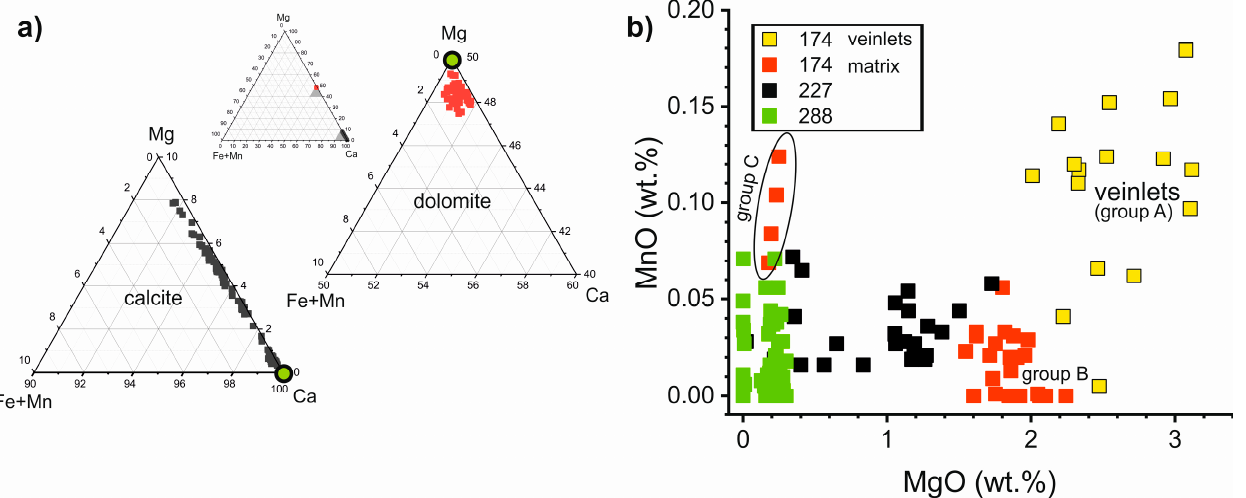
Figure 3. Summary of the chemical composition of the carbonate grains studied: ( a ) triangular plot of the main carbonate components. The composition of pure calcite and pure dolomite is indicated by green circles. The small triangle localizes the position of the two large triangles in the full-size plot; ( b ) the distribution of Mg- and Mn-admixture in calcite. Note the positive linear correlation between Mg and Mn for most of the data of sample No. 174. Sample No. 174—Raspenava; sample No. 227—Bohdane č ; sample No. 288—Nedv ě dice. Data of sample No. 174 can be subdivided into three groups (A—veinlets, B—groundmass of the calcitic type of dolomitic marble, C—groundmass of the dolomitic marble type with secondary calcite veins).